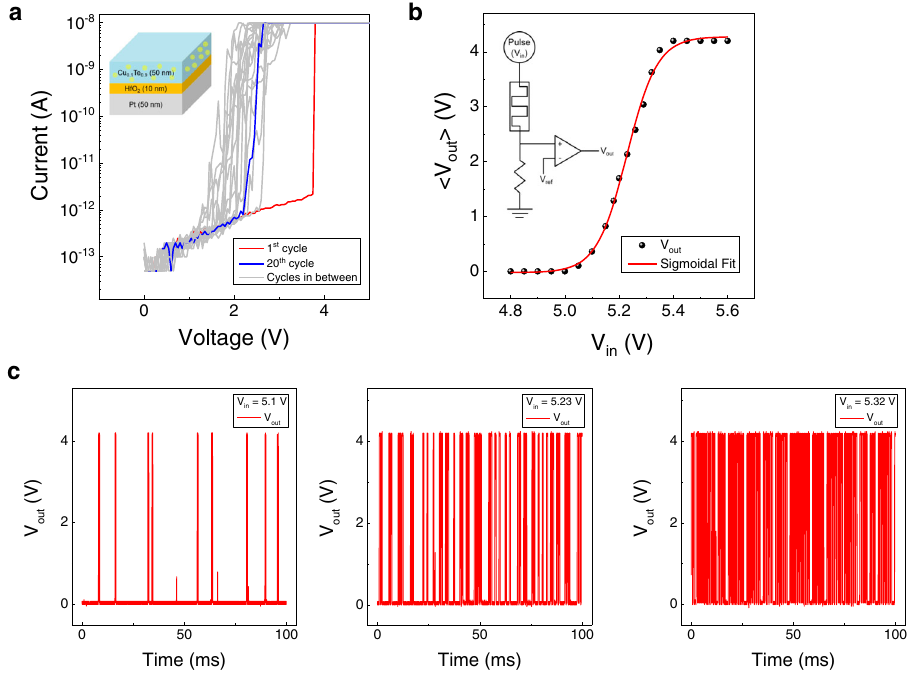
Fig. 2 |A p-bitdemonstrationusing aCTHP memristor.a I-Vcurves of the CTHP memristorwithaschematicoftheCTHPmemristorshownintheinset. b Averaged V out as a function of V in with a sigmoidal fi tting curve. The inset shows a circuit